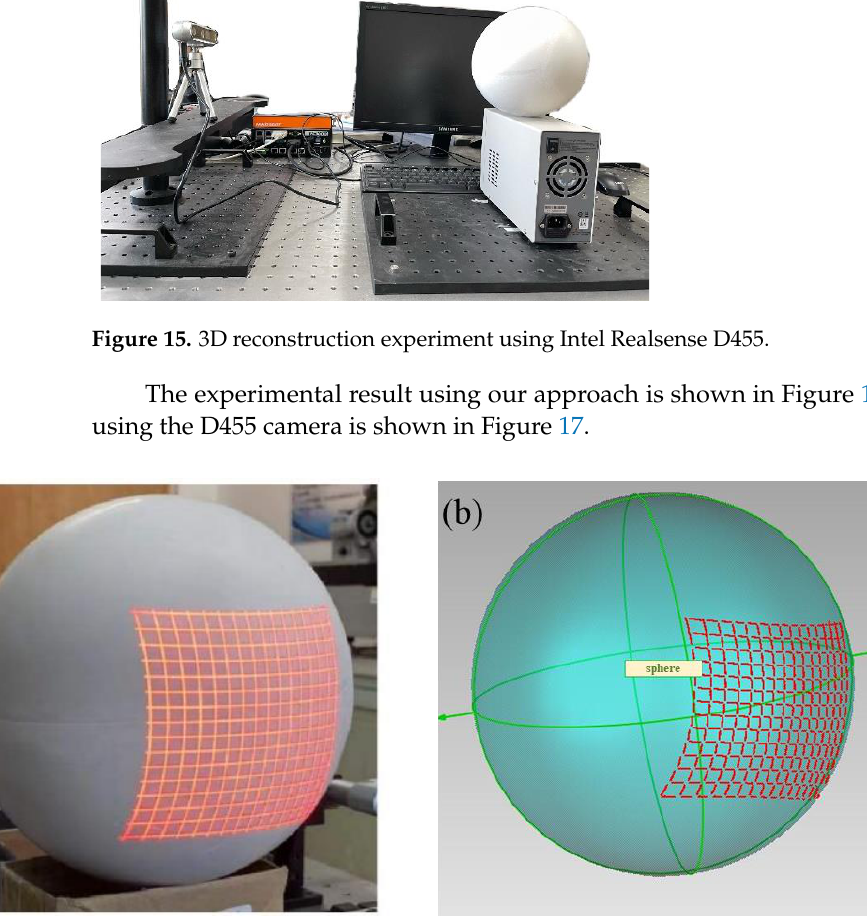
Figure 16. The 3D reconstruction of a sphere object using our approach. ( a ) Grid pattern image on the sphere; ( b ) Three-dimensional reconstruction result.